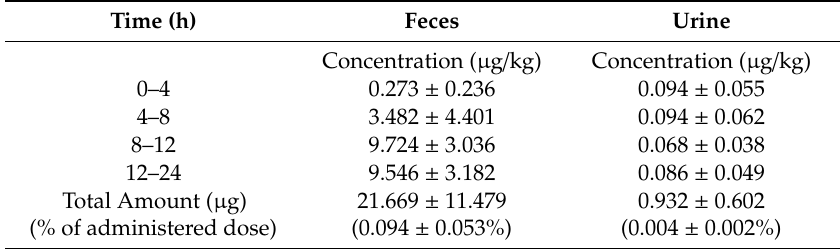
Table 4. Fecal and urinary excretion of Erinacine S after oral administration of the H. erinaceus